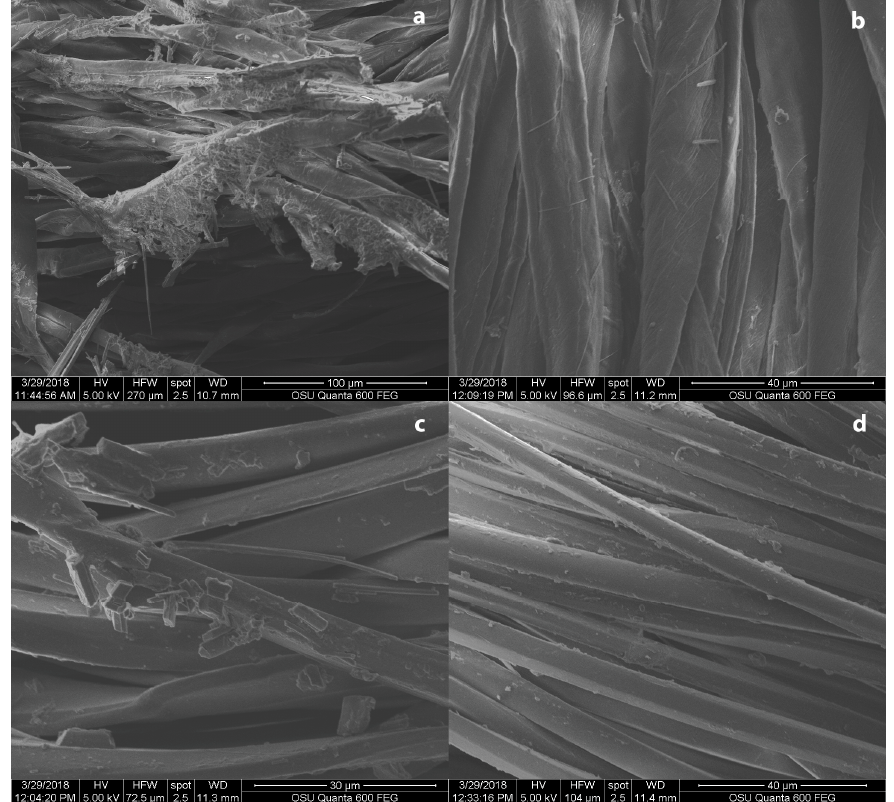
Figure 6. Dripping test results across several fabrics, with acetone: ( a ) Acetone-based ink dripping showing crystal clusters (pointed with a red arrow); ( b ) immersion on cotton fibers; ( c ) Acetone-based ink dripping and ( d ) immersion on polyester fibers. Crystallization is generally larger in acetone than ethanol, hence the change in micron size. Images taken with a FEI Quanta